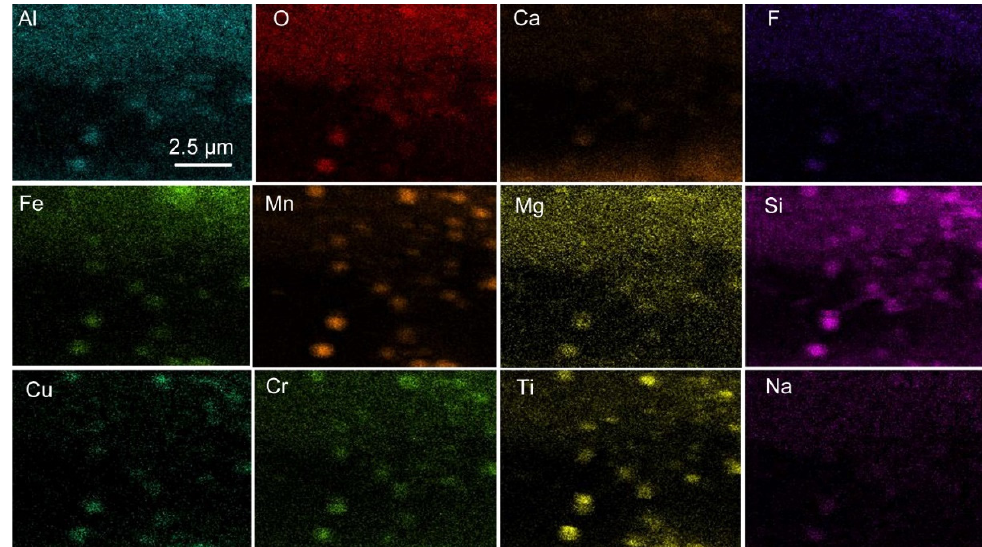
Figure 9. EDX map of marked area in Figure 6f: MP4 slag sample.